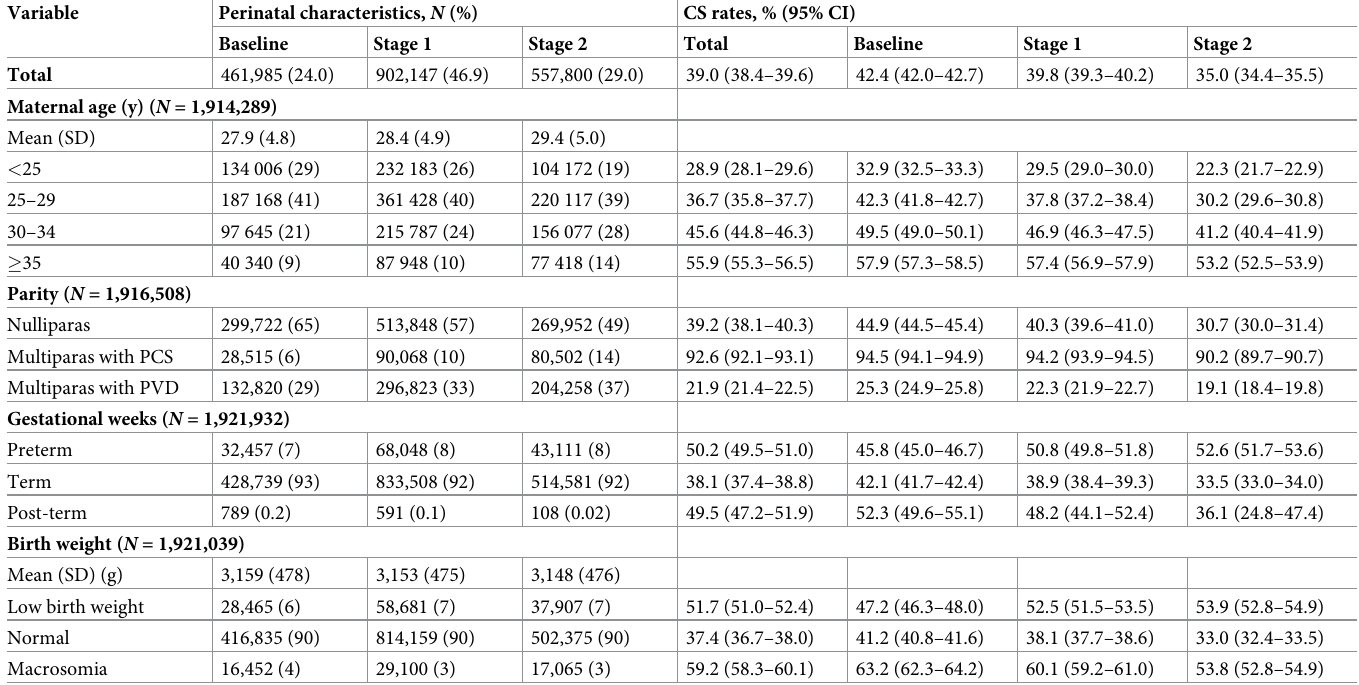
Table 2. Perinatal characteristics and CS rates by intervention stages among all births in Guangzhou, China, 2008–2016 ( n =